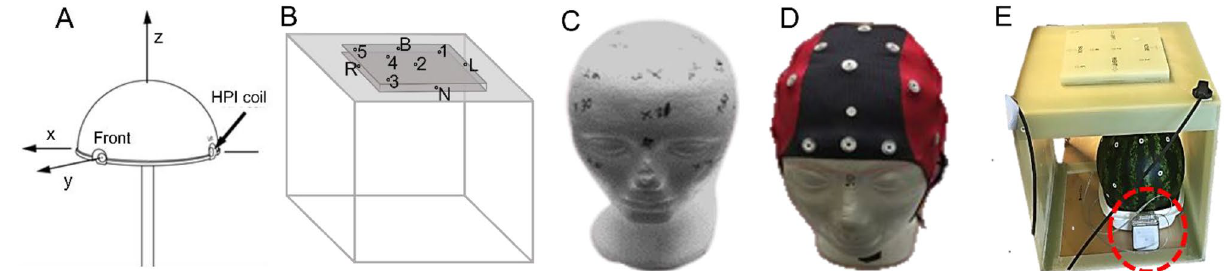
Figure 4. Models used for testing digitization accuracy. ( A ) Spherical MEG phantom, ( B ) 3D test frame, ( C ) Styrofoam head model with 35 marked points, ( D ) EEG cap with 32 electrodes, ( E ) Setup for the digitization test with an active DBS device (red dotted